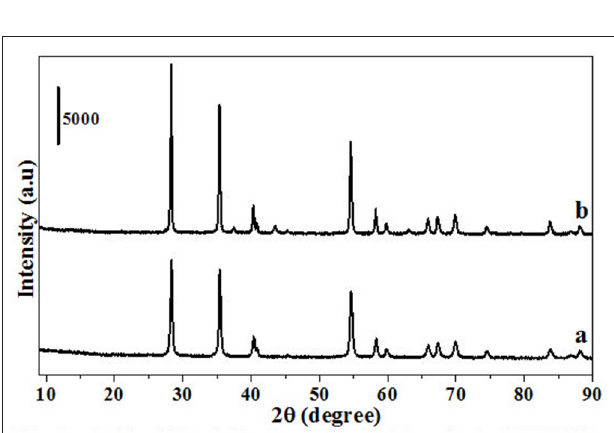
FIGURE 7 | py-FTIR of the catalyst precursor HRO/Na- β